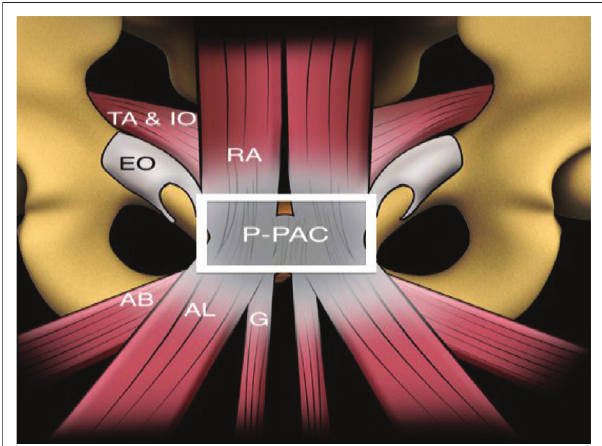
FIGURE 2: Prepubic aponeurotic complex (P-PAC).